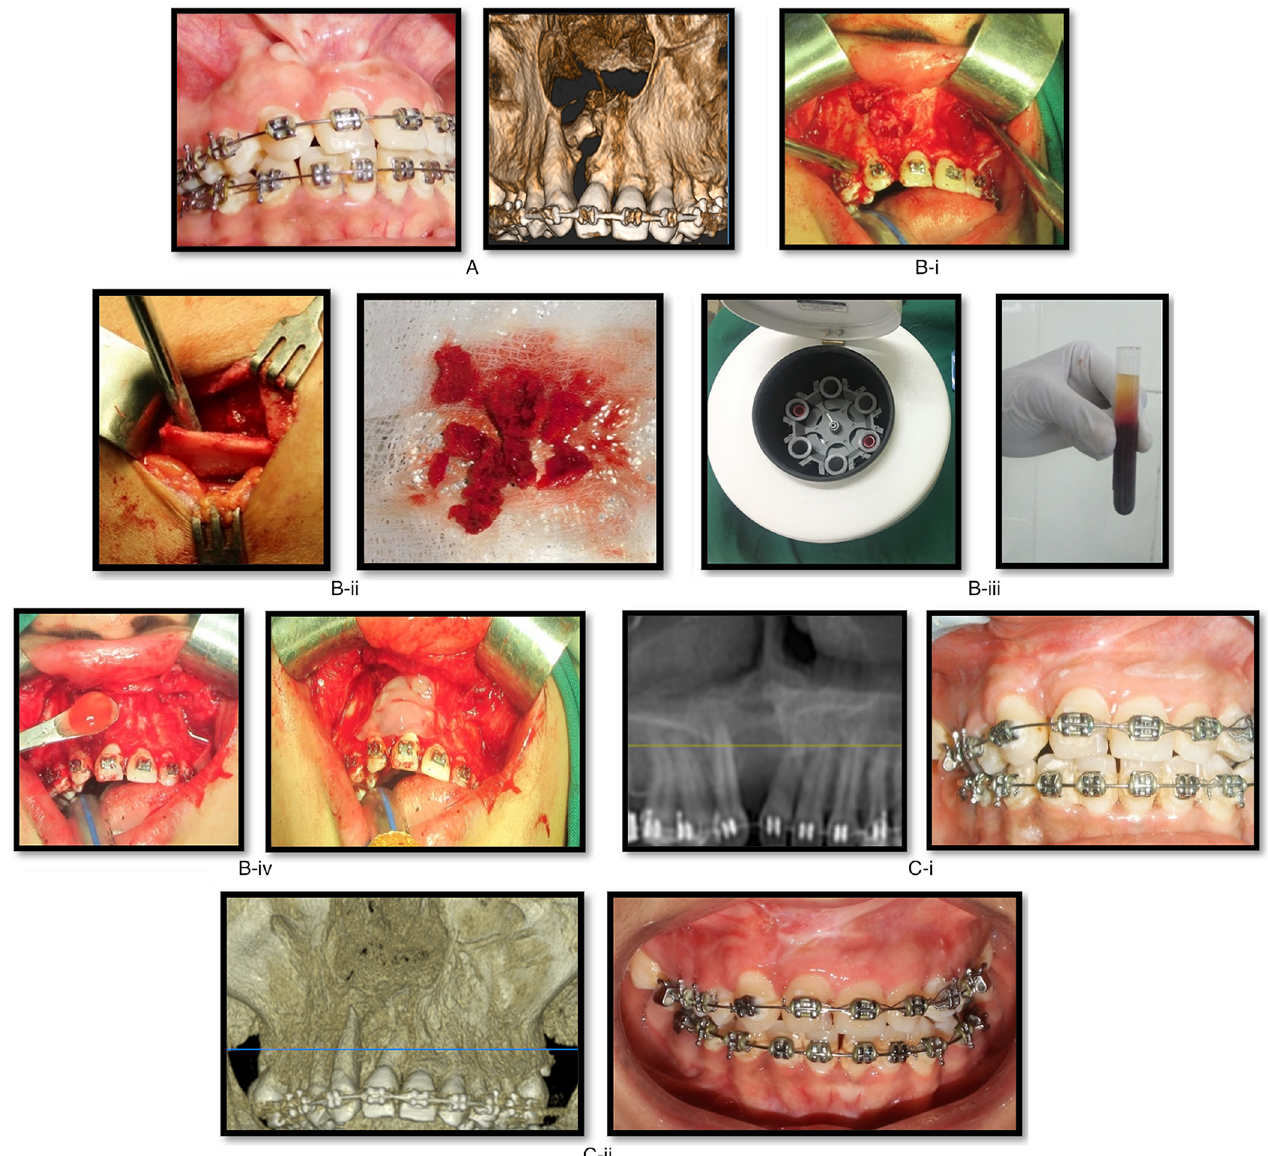
Fig. 1. Case of cleft alveolus defect on the right side with oro-nasal fi stula. (A) Preoperative images. (B) Intraoperative images. i) Exposure of cleft defect with fi stula and preparation of recipient site; ii) Trap door approach for anterior iliac bone graft harvesting; iii) Preparation of PRP and PRF with autogenous blood in centrifuge. iv) Placement of bone graft with PRP and coverage with PRF membrane of the defect area. (C) Postoperative images. (i) 3rd (cid:1) month postoperative images; (ii) 6th (cid:1) month postoperative